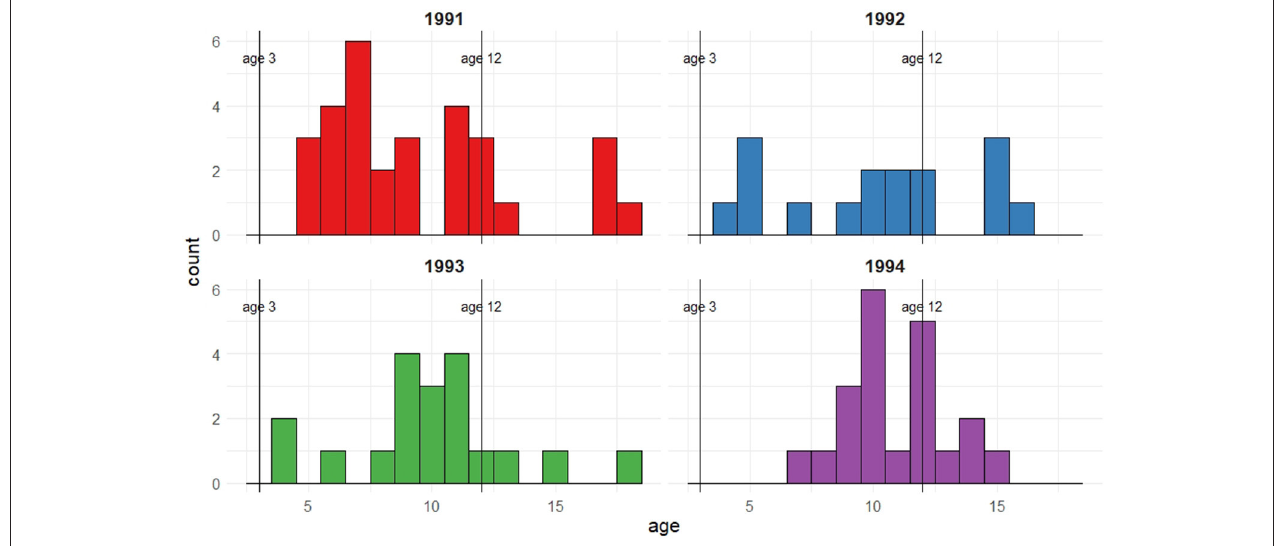
FIGURE 1 | Female pups born and tagged in 1991, 1992, 1993, and 1994 that were recaptured as breeding mothers between 1992 and 2011. The figure shows frequencies corresponding to age of first recapture for the different